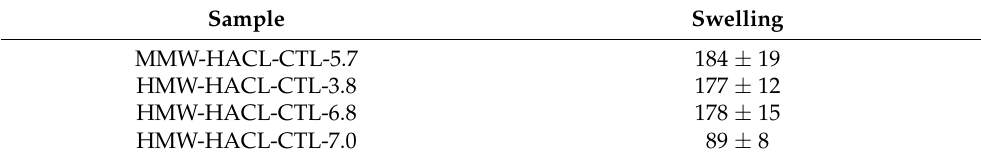
Table 3. Swelling results of HACL-CTL fillers in phosphate buffer solution at 37 ◦